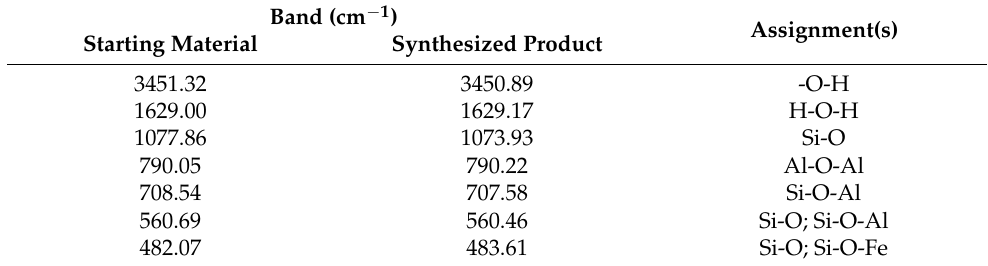
Figure 4. A comparative demonstration of the Fourier-transform (FT) infrared spectra of (a) the starting material and (b) treated product (synthesized muscovite). Table 4. The infrared (IR) absorption bands for the starting material and synthesized product .